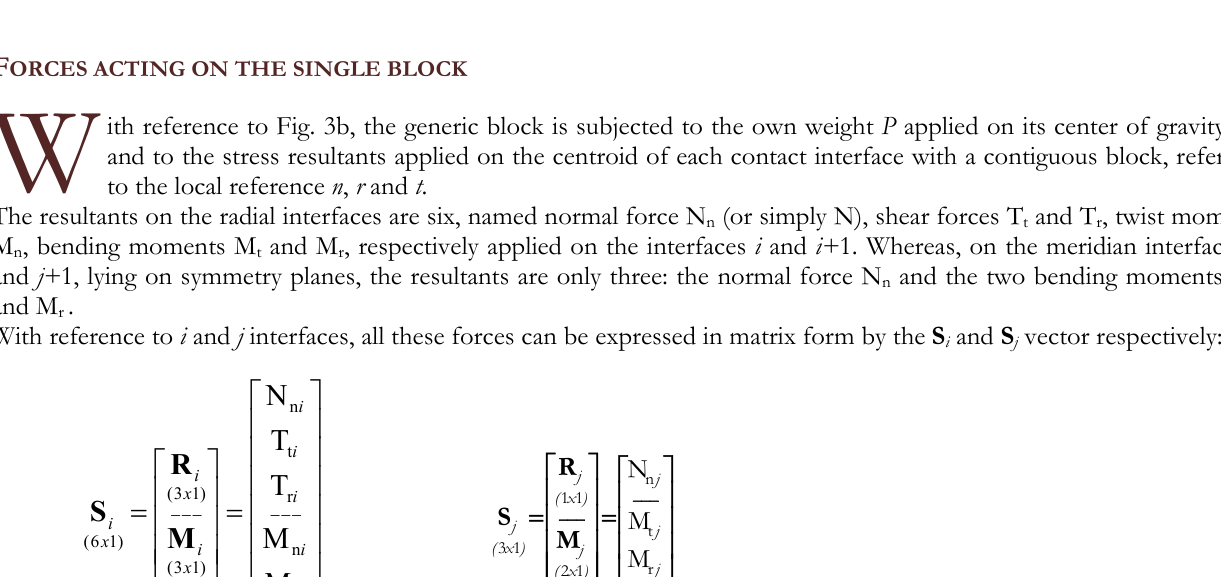
Figure 3: (a) Fixed and local references; (b) Own weight P acting in the G centroid of block and stress resultants applied on the i radial face and on j meridian face.